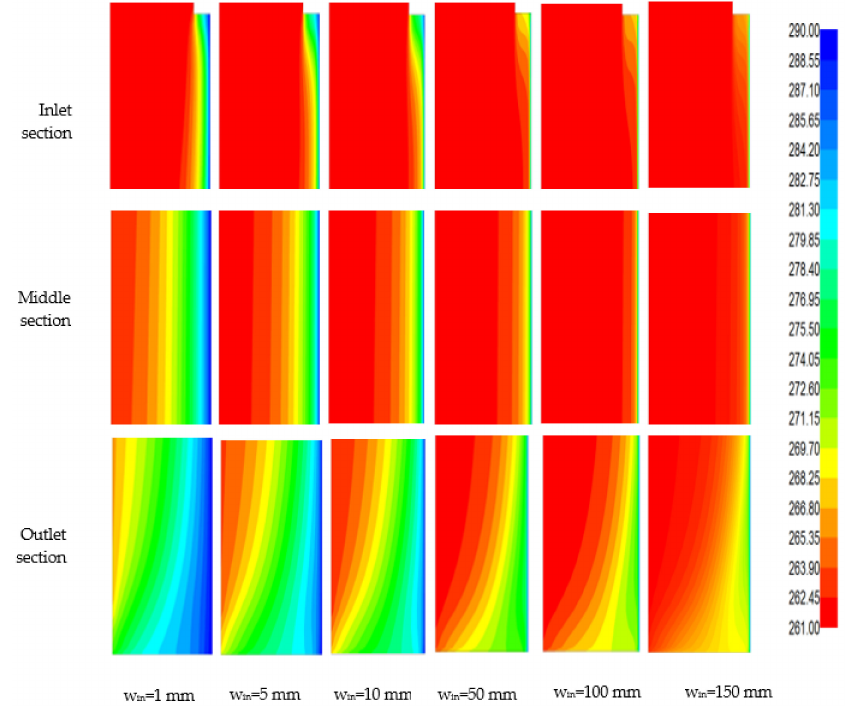
Figure 9. Temperature cloud in the cavity variation with the width of the air inlet (unit: